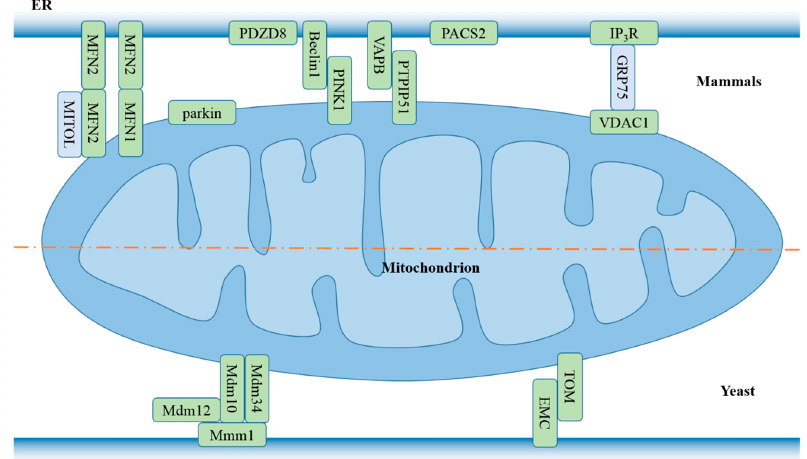
Figure 2. Structural components of mitochondria-associated ER membranes (MAMs). In mammalian cells, ER MFN2 tethers the ER to mitochondria by participating in homotypic or heterotypic interaction with mitochondrial MFN1 and MFN2 [44]. Mitochondrial ubiquitin ligase MITOL (also called MARCH5) interacts with and ubiquitinates mitochondrial MFN2, but not ER MFN2, to regulate MAM formation [45]. Parkin, through its N-terminal ubiquitin-like domain [46] and PDZD8 [47] engages in MAM formation, and favors Ca 2 + transfer from the ER to mitochondria.